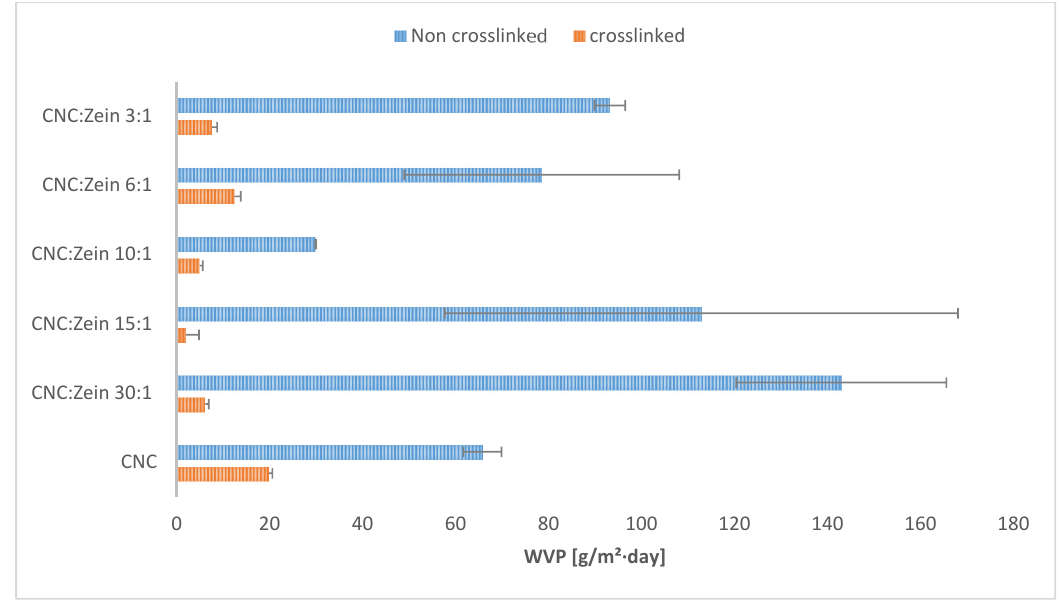
Figure 5. WVP of nanocomposite CNC/CZ film as affected by different CZ concentration and crosslinking.